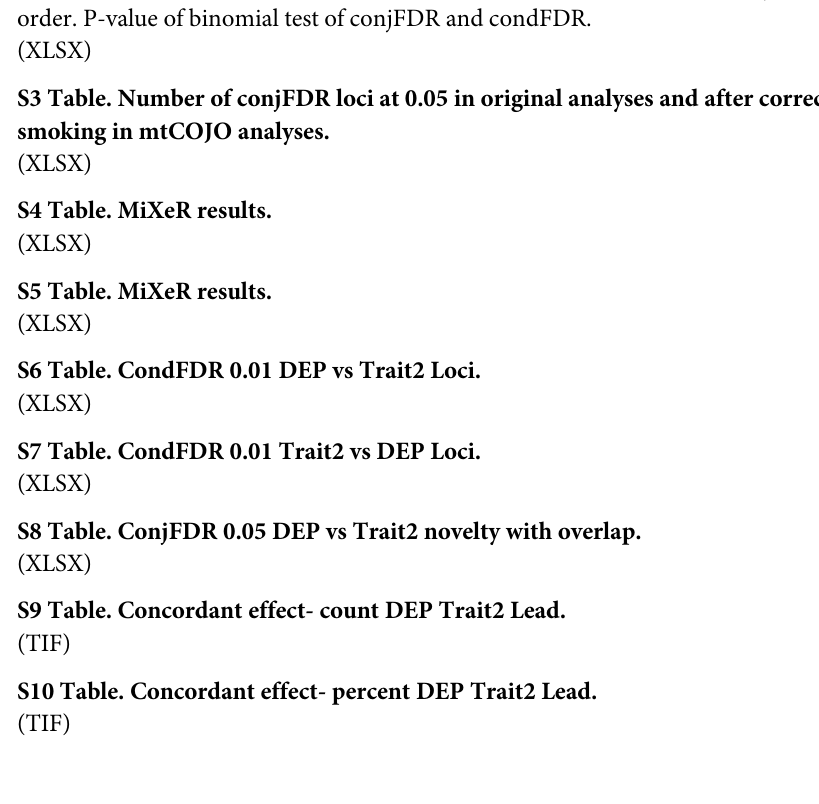
S36 Fig. Zoom plot for DEP and DBP centered on the variant rs174576, close to the Fatty Acid Desaturase 2 ( FADS2 ) gene. (TIF) S37 Fig. Zoom plot for DEP and HDL centered on the variant rs174594, close to the Fatty Acid Desaturase 2 ( FADS2 ) gene. This leadSNP was in common for depression, HDL, LDL, TC and TG. S38 Fig. Zoom plot for DEP and LDL centered on the variant rs174594, close to the Fatty Acid Desaturase 2 ( FADS2 ) gene. This leadSNP was in common for depression, HDL, LDL, TC and TG. S39 Fig. Zoom plot for DEP and TC centered on the variant rs174594, close to the Fatty Acid Desaturase 2 ( FADS2 ) gene. This leadSNP was in common for depression, HDL, LDL, TC and TG. S40 Fig. Zoom plot for DEP and TG centered on the variant rs174541, close to the Fatty Acid Desaturase 2 ( FADS2 ) gene. This leadSNP was in common for depression, HDL, LDL, TC and TG. S1 Table. Description of the five additional cohorts. S2 Table. Replication of our results in FinnGen MDD sample. MDD: Major depressive dis- order. P-value of binomial test of conjFDR and condFDR. S3 Table. Number of conjFDR loci at 0.05 in original analyses and after correcting for smoking in mtCOJO analyses. S4 Table. MiXeR results. S5 Table. MiXeR results. S6 Table. CondFDR 0.01 DEP vs Trait2 Loci. S7 Table. CondFDR 0.01 Trait2 vs DEP Loci. S8 Table. ConjFDR 0.05 DEP vs Trait2 novelty with overlap. S9 Table. Concordant effect- count DEP Trait2 Lead. S10 Table. Concordant effect- percent DEP Trait2